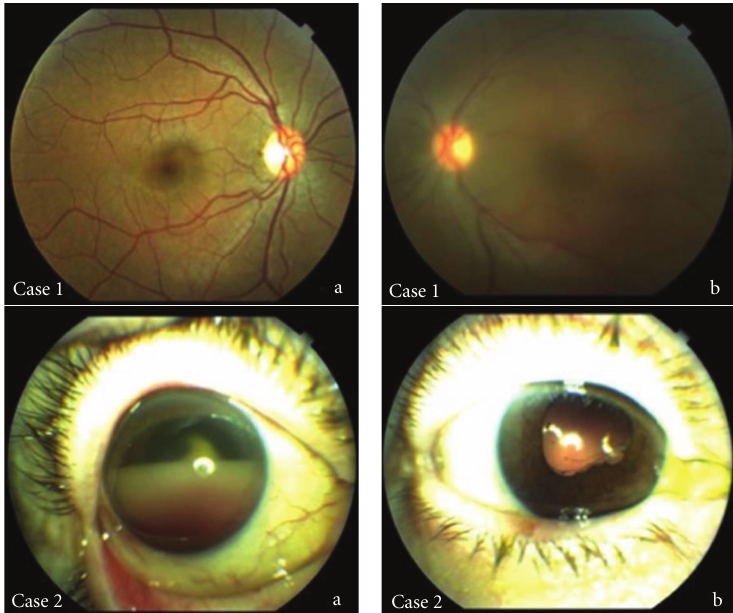
Figure 2: Case 1: (a) healthy right eye of the same patient, (b) left eye vitreitis in a healthy patient that was finally diagnosed of primary vitreoretinal lymphoma by vitrectomy. Case 2: (a) hemorrhagic hypopion in a patient with primary thoracic B-cell Hodgkin’s lymphoma in clinical remission. After unsuccessful anti-inflammatory and antibiotic treatment an anterior chamber paracentesis was performed confirming the diagnosis of metastatic lymphoma, (b) external aspect of the eye after treatment with intravitreal